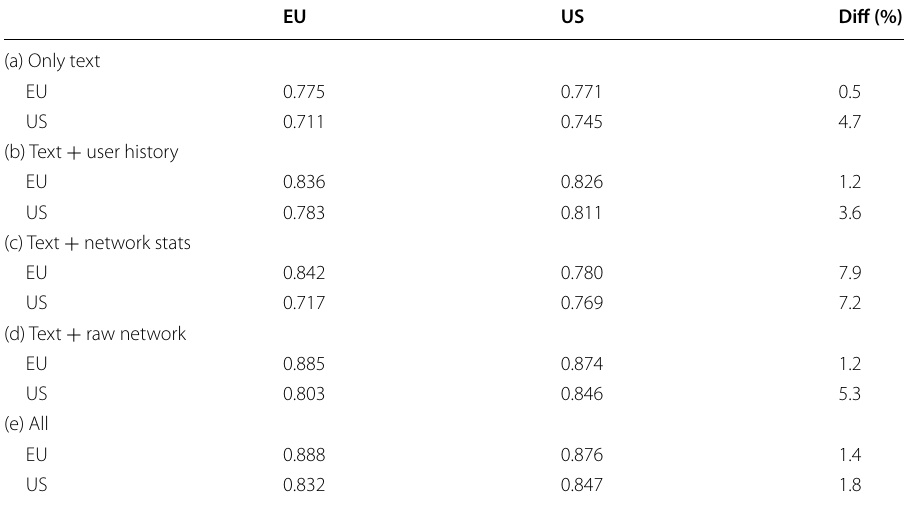
Table 5 Cross-region model evaluation for vax-skeptic content prediction with respect to different